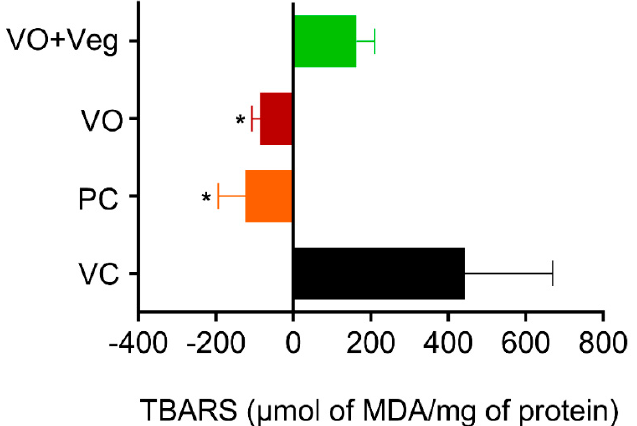
Figure 8. Delta levels of lipid peroxidation (TBARS) in skin experimental groups. Data are expressed as mean ± SEM * p < 0.05. One-way ANOVA followed by Tukey’s post hoc test.